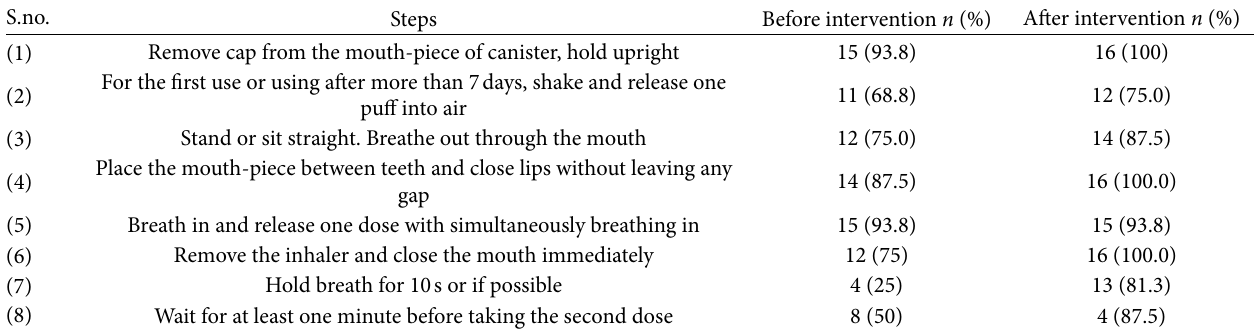
Table 7: Percentage of patients performing each step